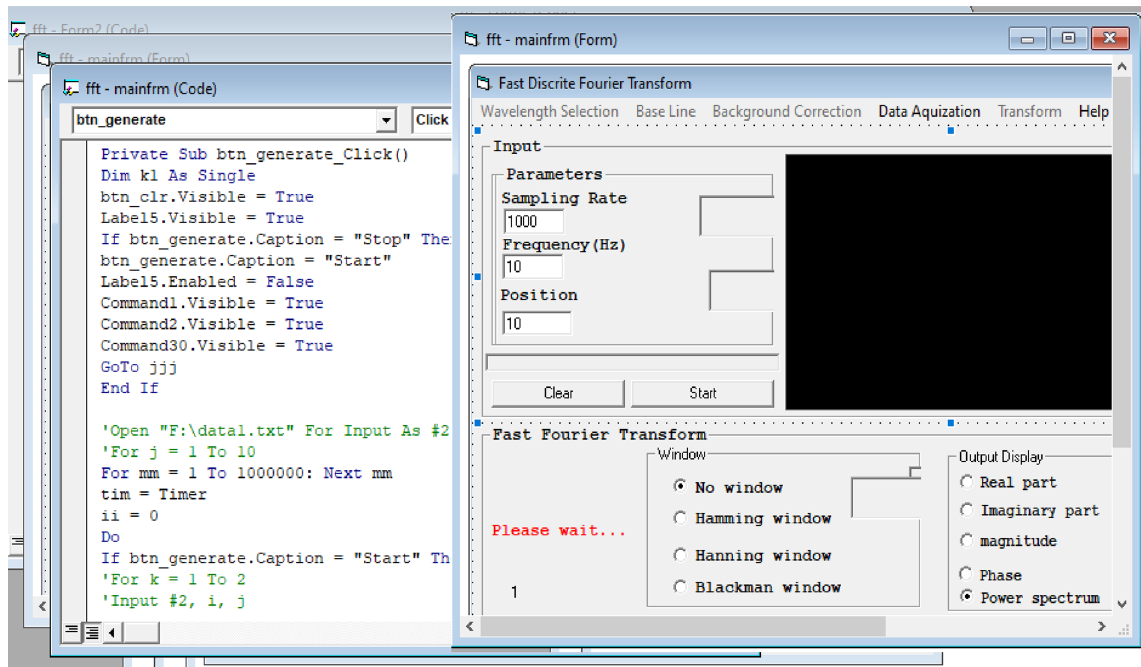
Figure 5. Written Visual Basic 6 ( VB 6 ) software to apply the DFFT algorithm to the time domain